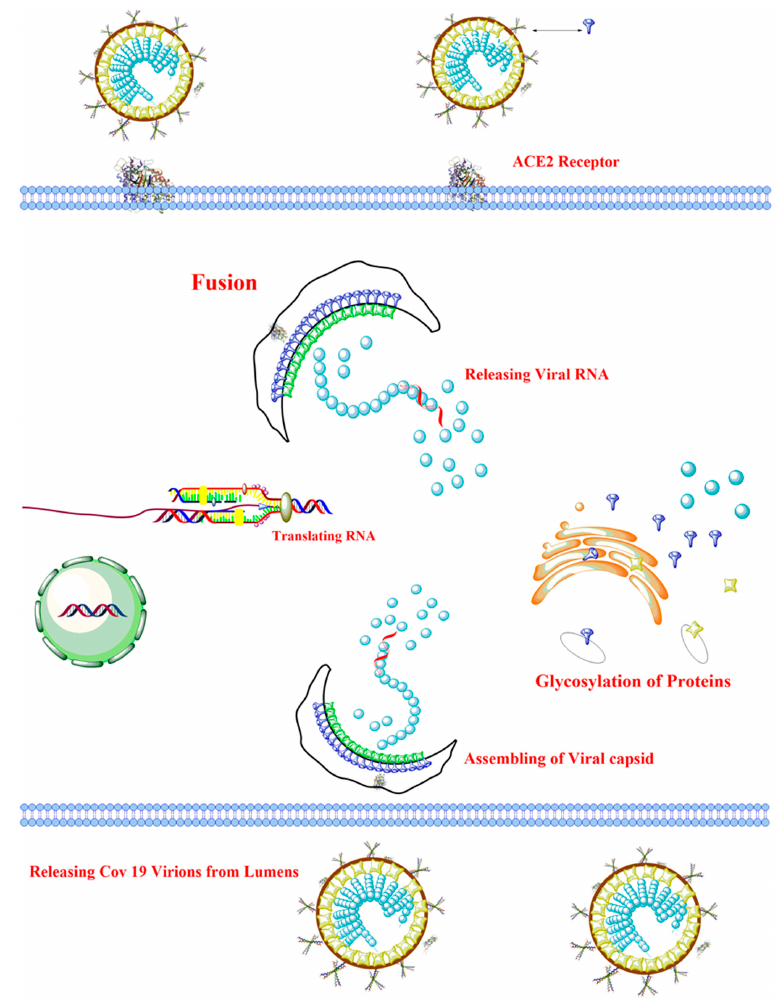
Figure 2. Scheme of Covid-19 pathogenicity mechanism.